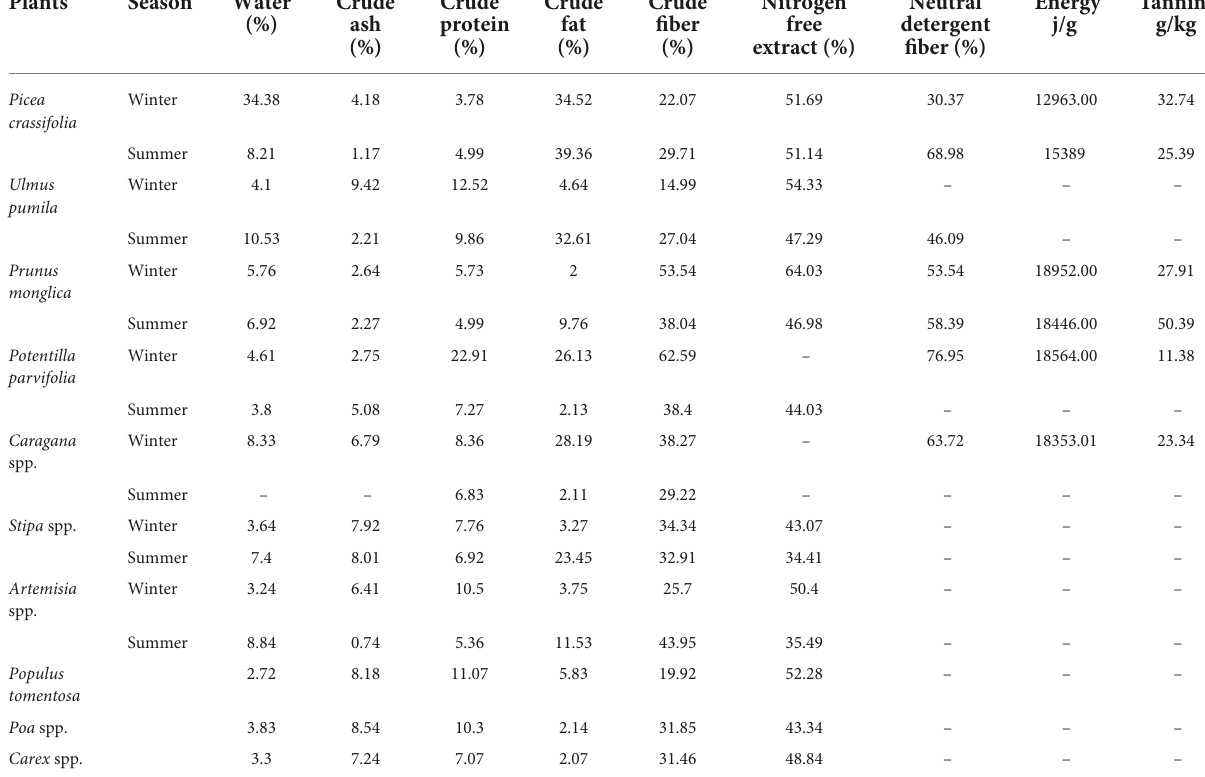
TABLE 2 The nutrition of plants fed by blue sheep and red deer. Plants Season Water